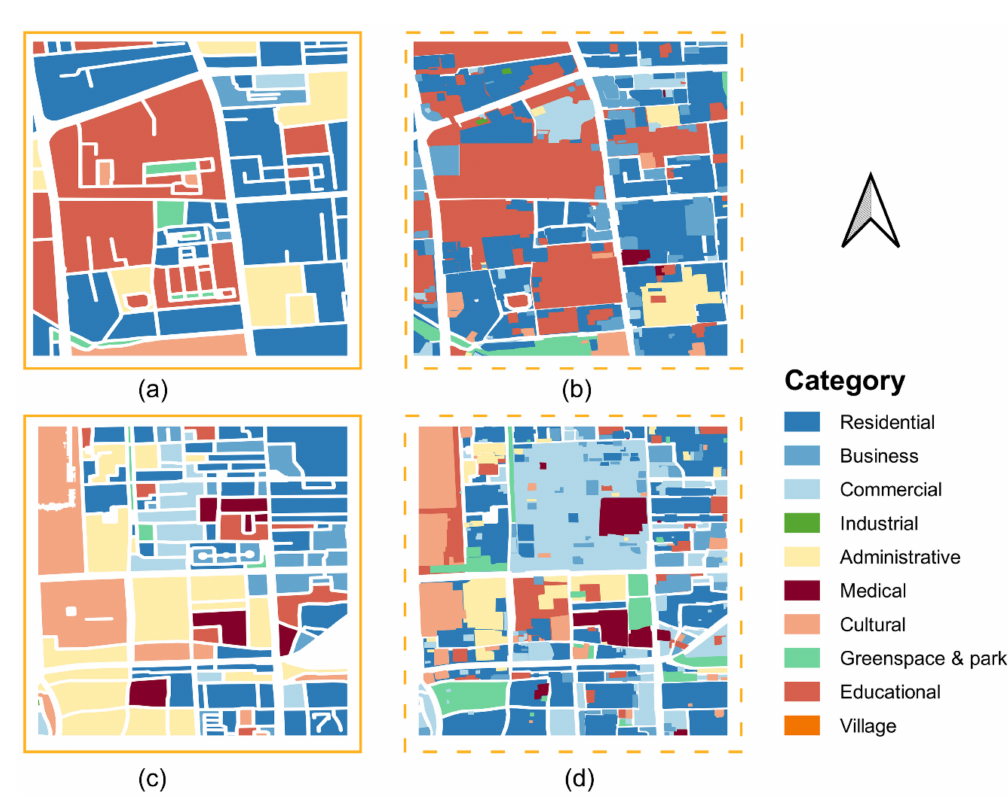
Figure 21. Comparison of the mapping results in this study with that in EULUC-China. ( a , c ) Zoomed-in views of the mapping results of EULUC; ( b , d ) zoomed-in views of the mapping results in this